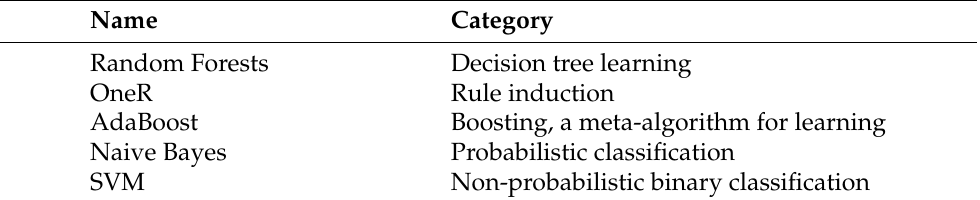
Table 2. Machine learning algorithms and their respective